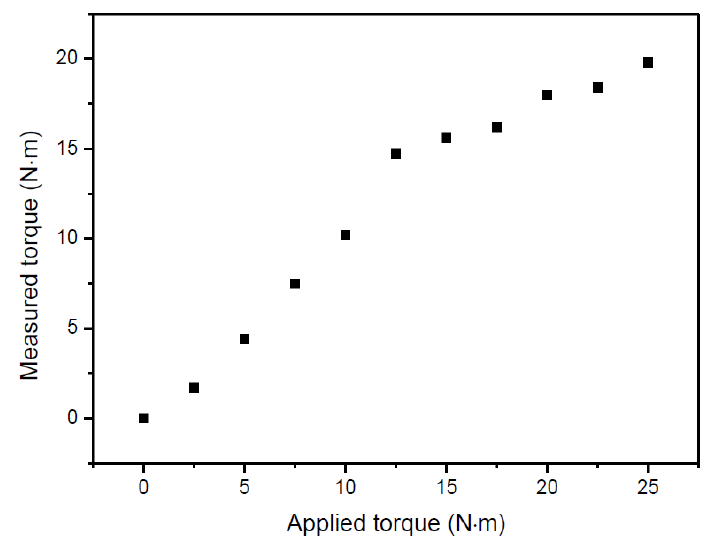
Figure 13. Torque measured by the strain sensors as a function of the torque applied by the braking system.